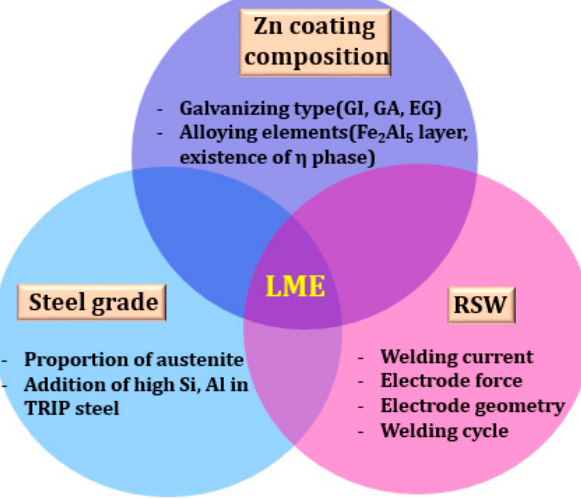
Figure 2. Conditions for the occurrence of Liquid metal embrittlement (LME).